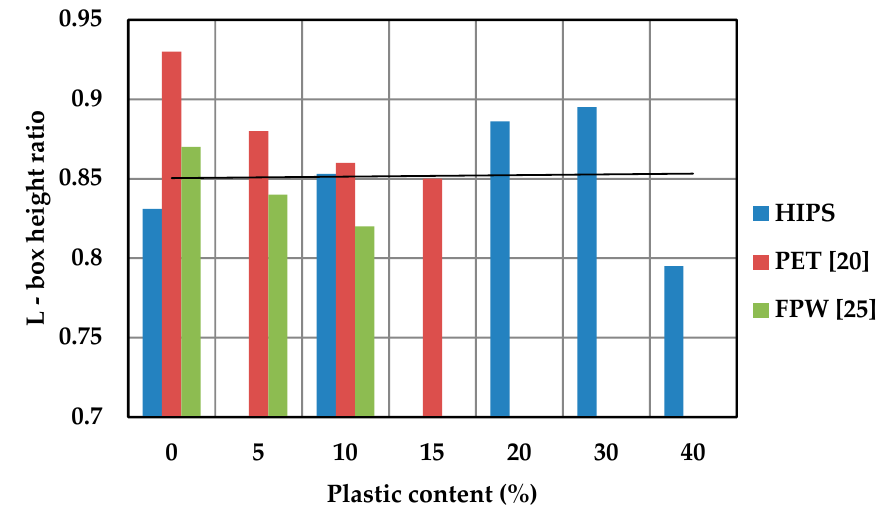
Buildings 2019 , 9 , x FOR PEER REVIEW Figure 6. L-box height ratio of SCC at different % of plastic content. Figure 6. L-box height ratio of SCC at different % of plastic content. 231